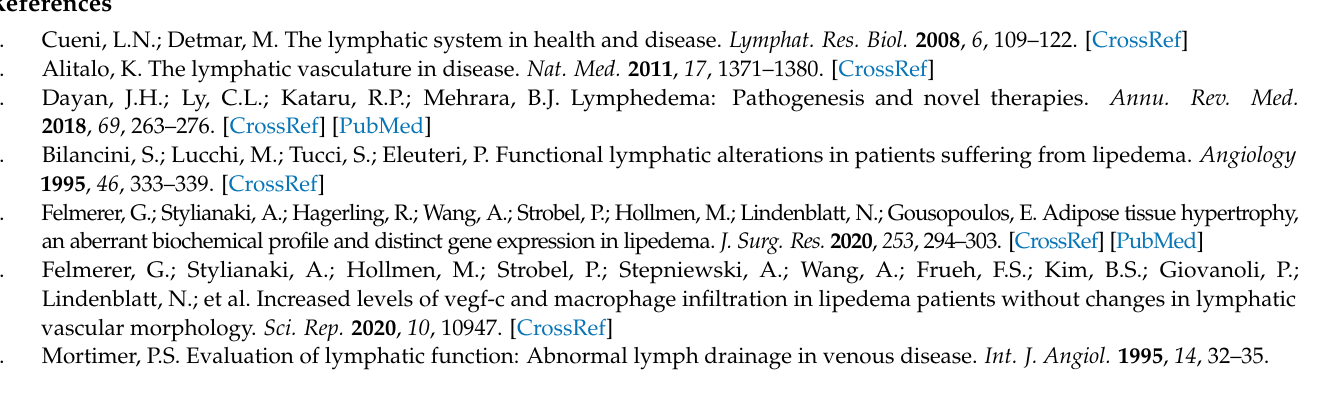
Figure S1: Linear relationship between ICG concentrations in purely aqueous solution, 5% and 20% HSA, and fluorescence intensity. ICG concentration range in which the relationship is linear, and respective R 2 of the fitted regression